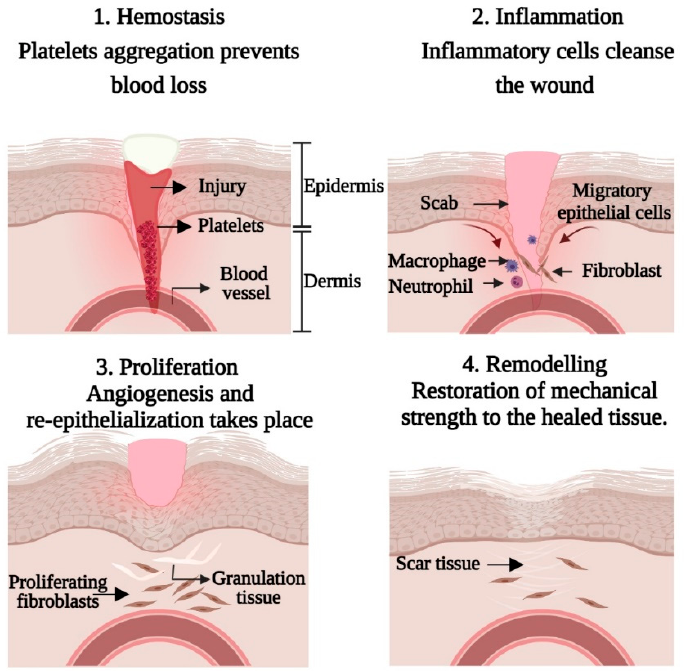
Figure 1. Regulated steps of wound healing ( 1 ) hemostasis; ( 2 ) inflammation; ( 3 ) proliferation and ( 4 ) remodeling of tissue (created with BioRender.com).